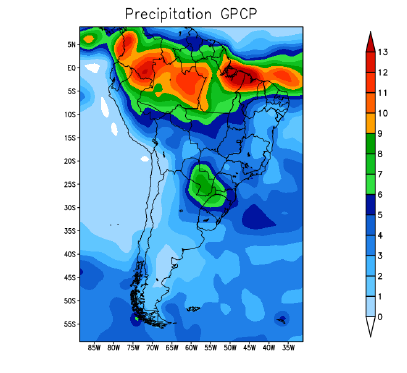
Figure 5. GPCP precipitation—autumn 2019.